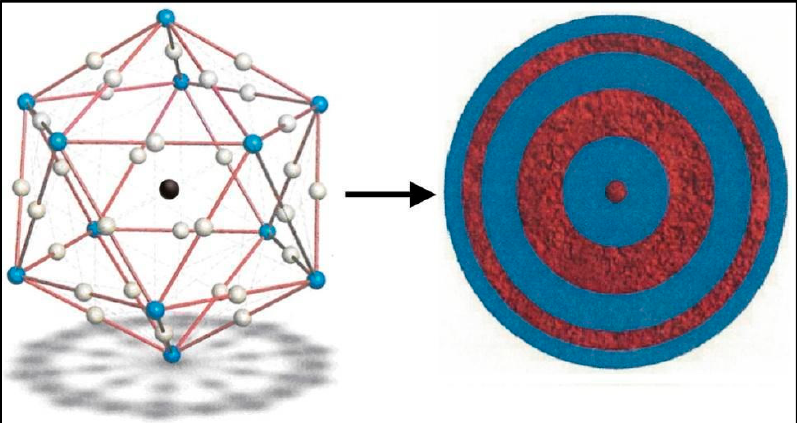
Figure 9. First variation of the corresponding body-centered unit cell transformed to a six-phase spherical unit cell.